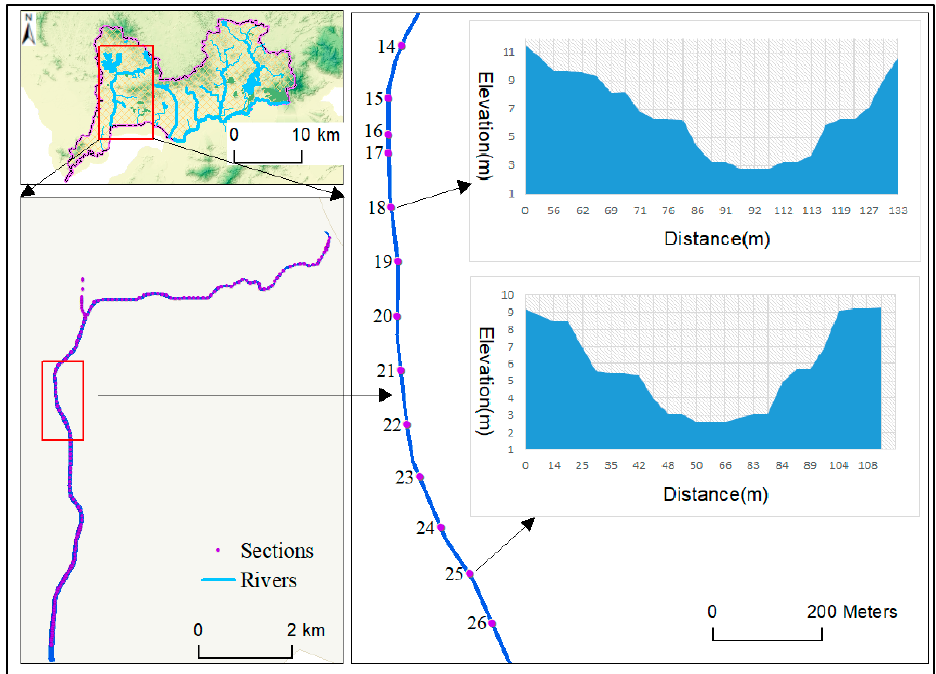
Figure 5. Distribution map of river section.